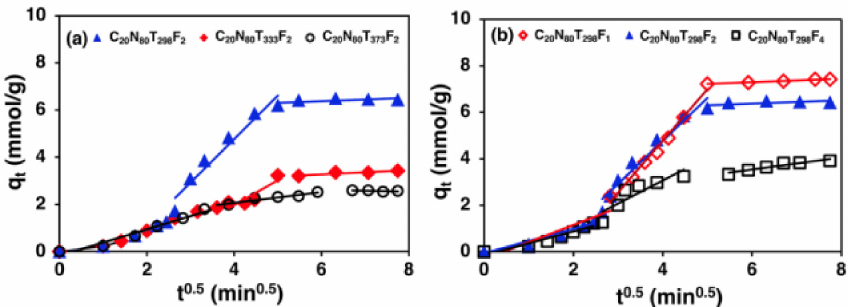
Figure 7. Intraparticle diffusion model plots of CO 2 adsorption on zeolite 5A at ( a ) different tempera- tures; ( b ) different feed flow rates.